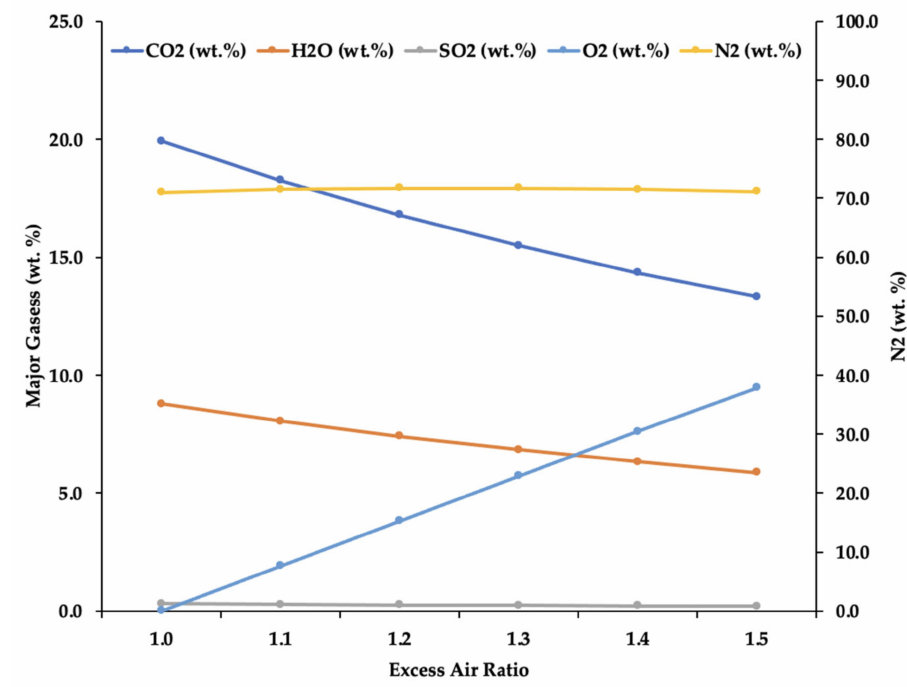
Figure 4. Gas composition in the flue gas under various EA